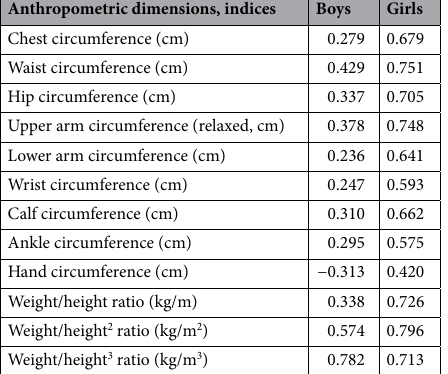
Anthropometric dimensions, indices